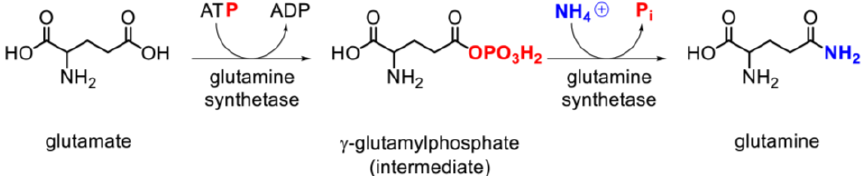
Figure 1. The reaction of glutamine synthetase. Schematic representation of the two-step reaction catalyzed by glutamine synthetase to form glutamine using glutamate, ATP, and ammonia as substrates. The phosphate originating from ATP is depicted in red, ammonium in blue.